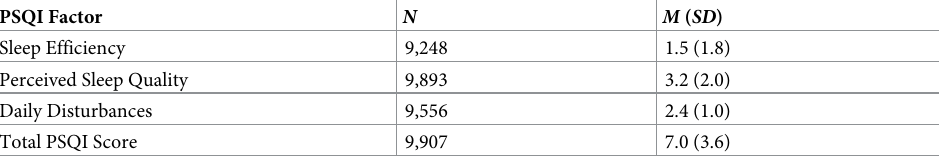
Table 2. PSQI total and component scores.